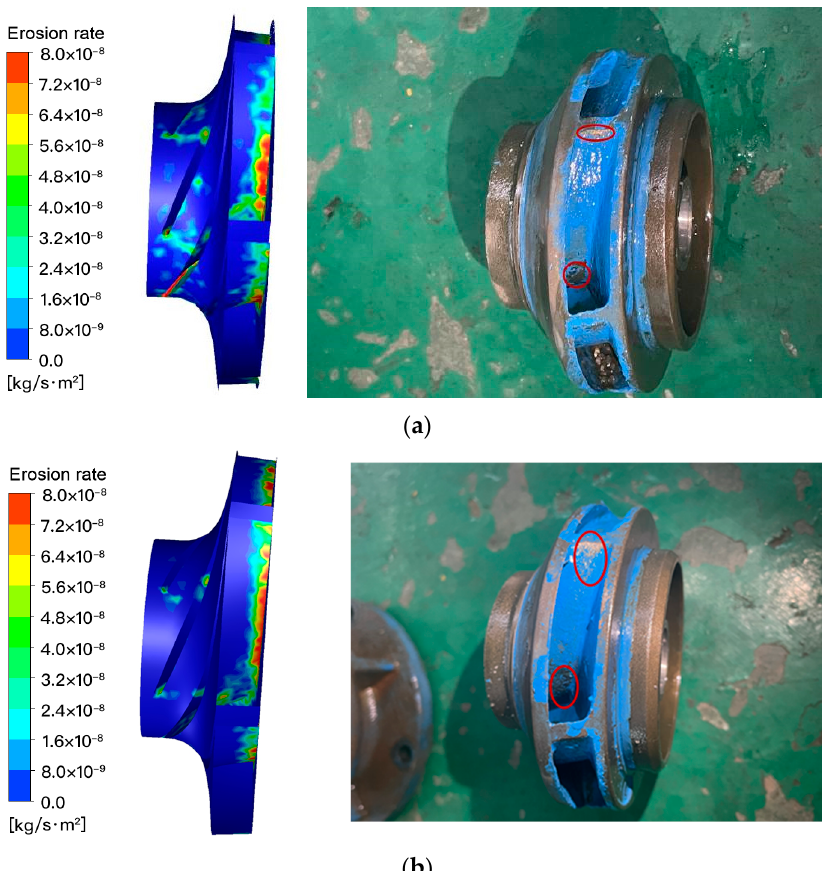
Figure 30. Comparison of numerical calculation results and test results of the erosion area under low flow conditions: ( a ) first stage impeller; ( b ) secondary impeller.